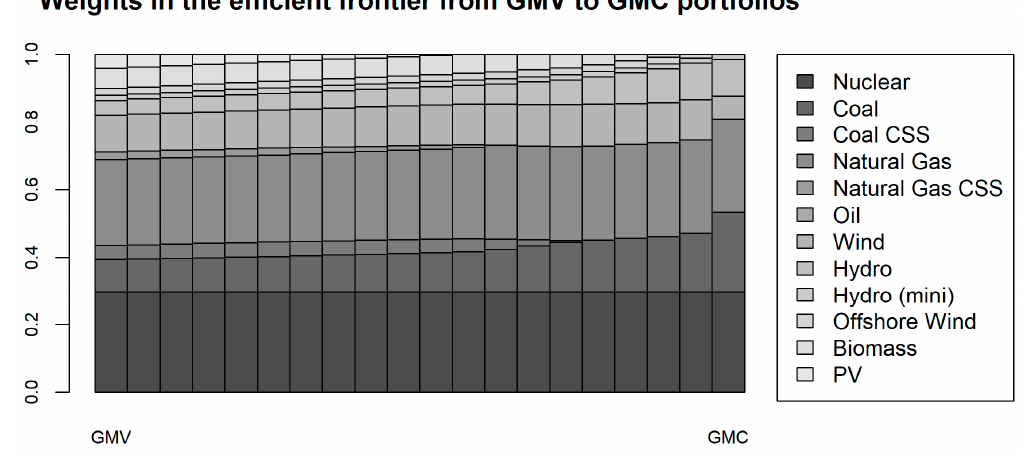
Figure 2. Technology participation in the instrumental mode.